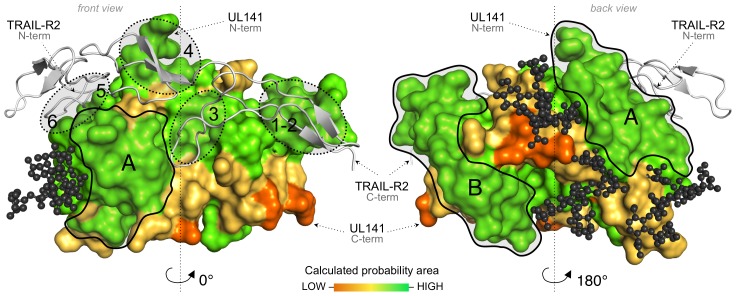
UL141 surface accessibility for receptor binding.Structure of one UL141 subunit (colored surface) in complex with one TRAIL-R2 (grey cartoon) shown in two views (0° and 180° turn). All three potential N-linked glycosylation sites (Asn117, Asn132 and Asn147) where modeled with a five-sugar Man2GluNac2Fuc glycans, shown in dark grey ball-and-stick). Area A and B indicate available and accessible protein binding sites on UL141, while other available areas are expected to be mostly covered with glycans in the fully glycosylated protein. Location of potential protein-protein binding sites for unbound UL141 were calculated using ProMate (http://bioinfo.weizmann.ac.il/promate). For simplicity, only one UL141 subunit is shown here in molecular surface colored from orange reflecting the lowest probability assigned, to green, assigned to the highest probability. The highest probability areas that reflect possible binding sites in UL141; excluding those binding sites 1–6 of TRAIL-R2 (shown in dotted line here); and are not shield by glycans, are areas A and B.